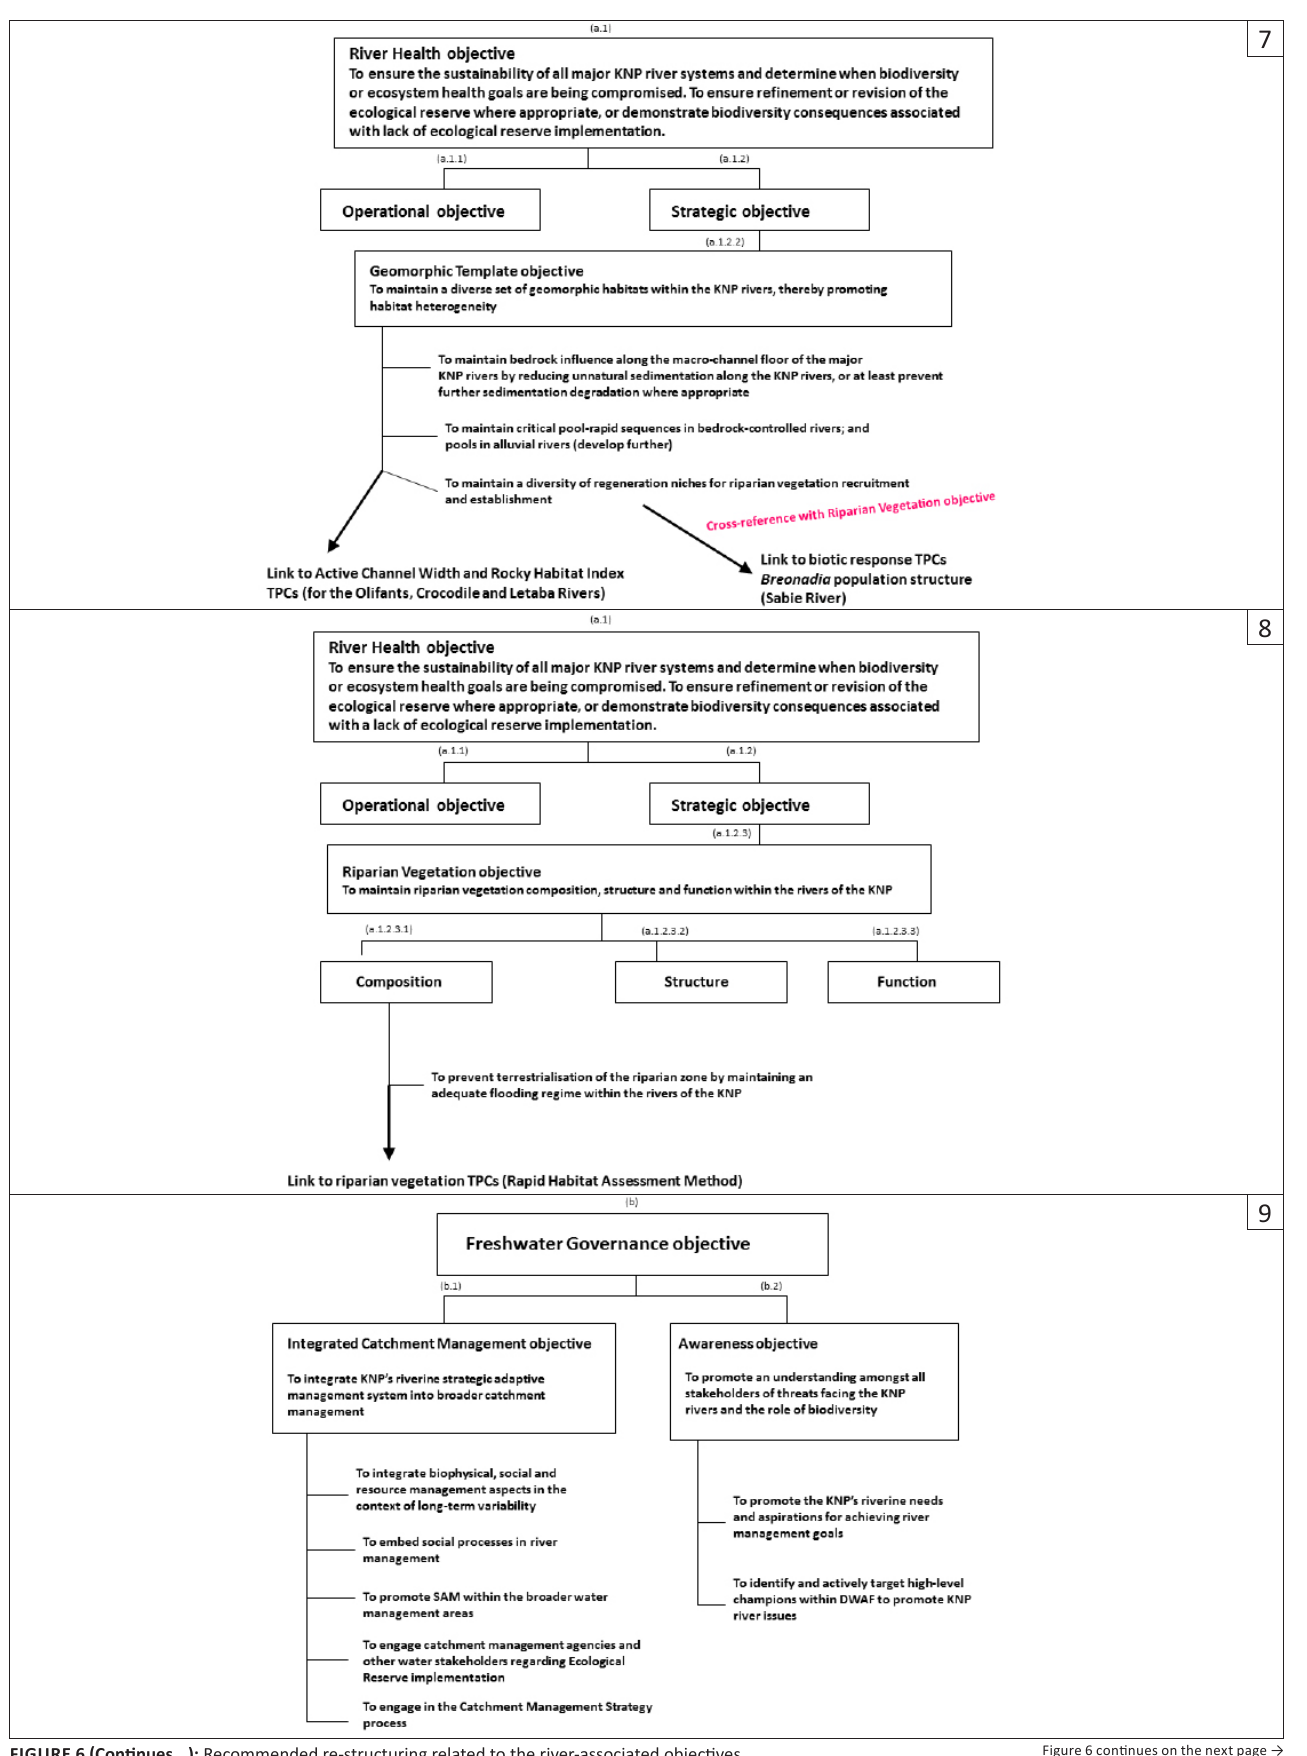
FIGURE 6 (Continues...): Recommended re-structuring related to the river-associated objectives. Figure 6 continues on the next page